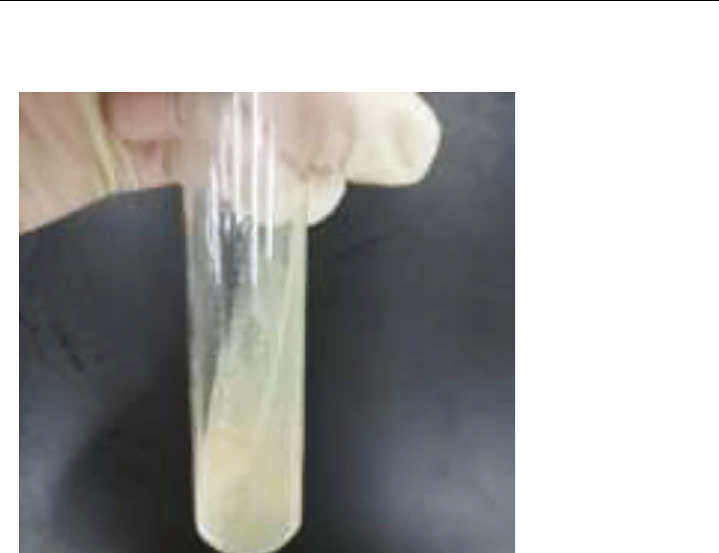
Figure 1: Agar slant.